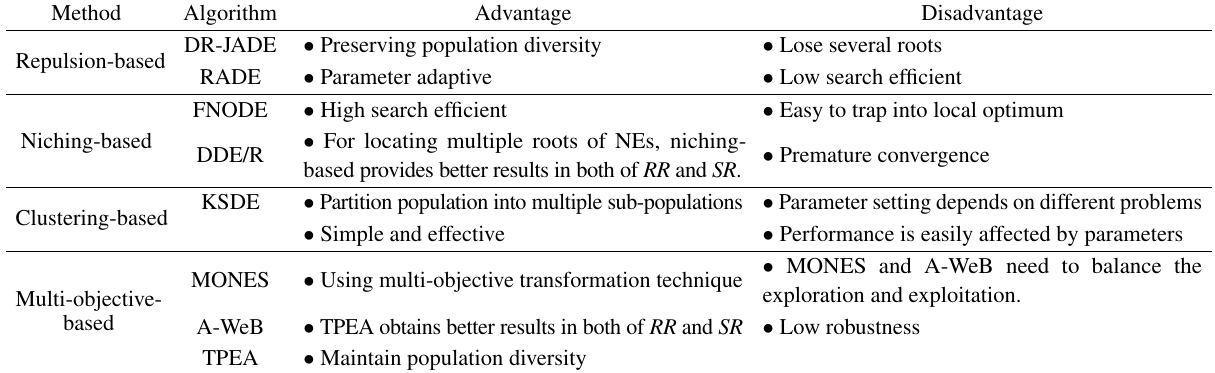
Summary of the advantages and disadvantages of the 8